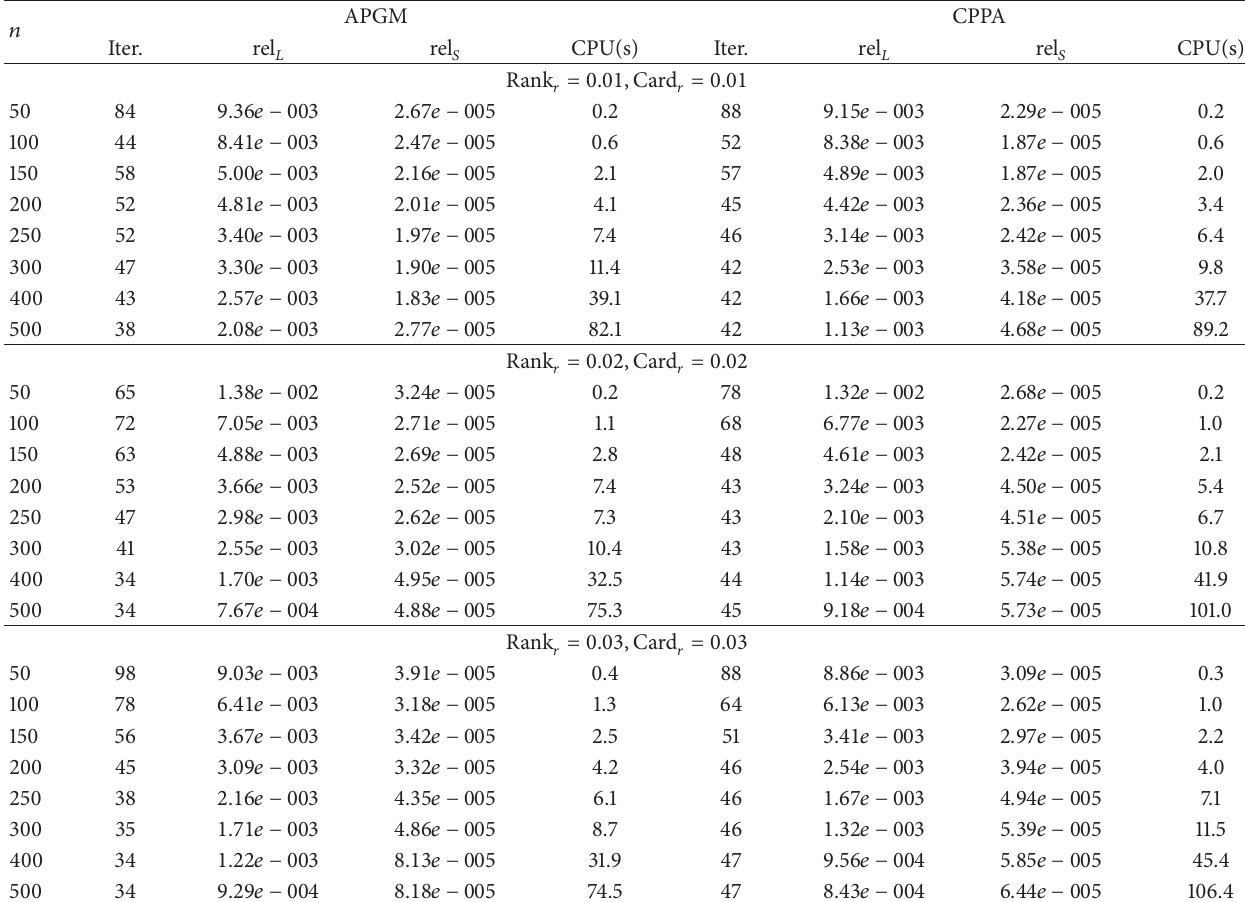
Table 1: Numerical results for stable principal component pursuit